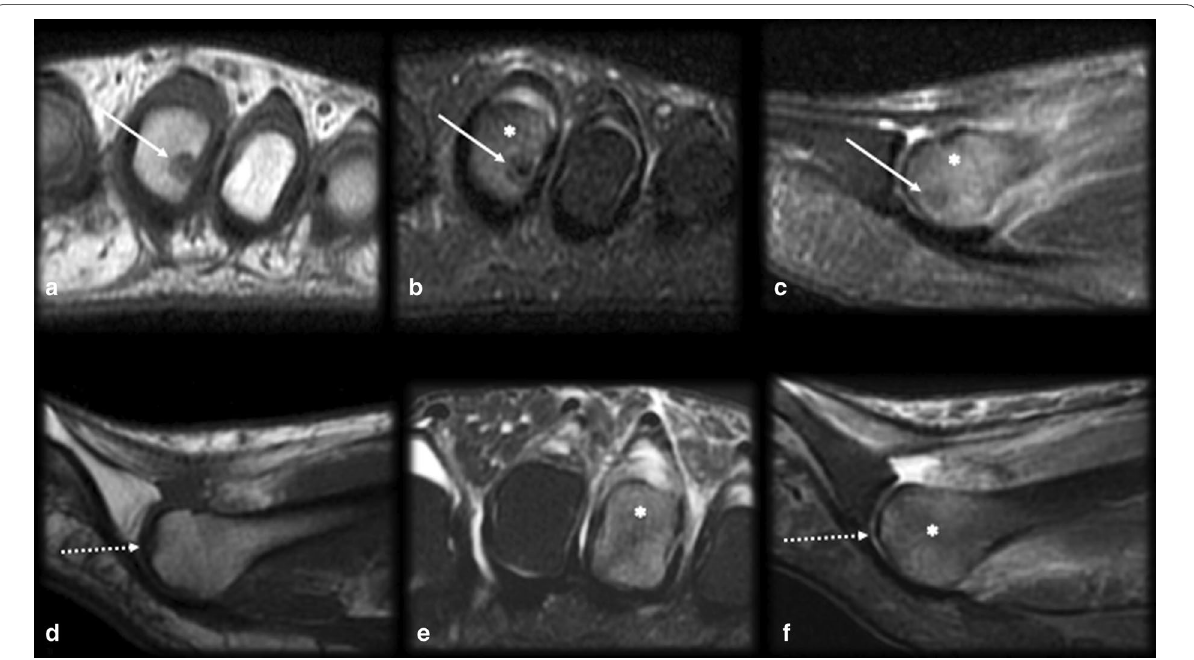
Fig. 11 Osteoid osteoma versus subchondral fracture. ( a – c ) Female, 32 years old, presenting with metatarsalgia for 2 months. T1 coronal ( a ) and T2 FS coronal ( b ) and sagittal ( c ) MRI showed a mineralized nidus (arrows) with reactional bone marrow and adjacent edema (asterisk). ( d – f ) Female, 33 years old, presenting with metatarsalgia for 3 weeks. T1 sagittal ( a ) and T2 FS coronal ( b ) and sagittal ( c ) MRI showed a subchondral fracture (dotted arrows) with bone marrow edema